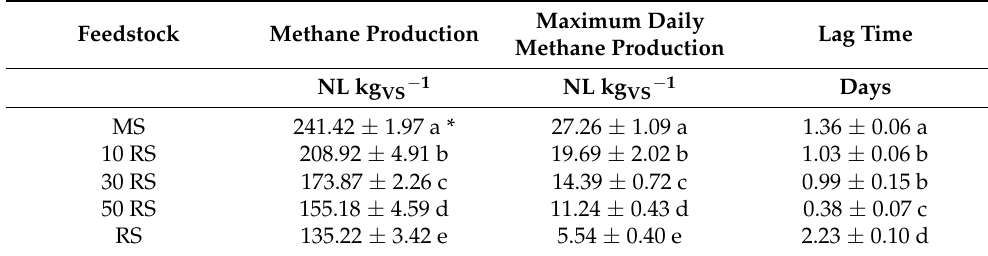
Table 2. Methane production and lag time of mono- and co-digestion of maize and reed silages. Feedstock